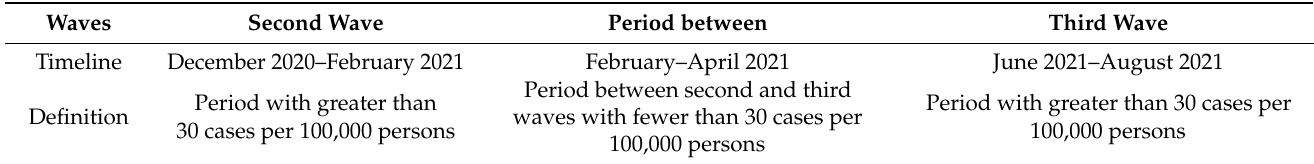
Table 1. Period of different COVID-19 infection waves as experienced in South